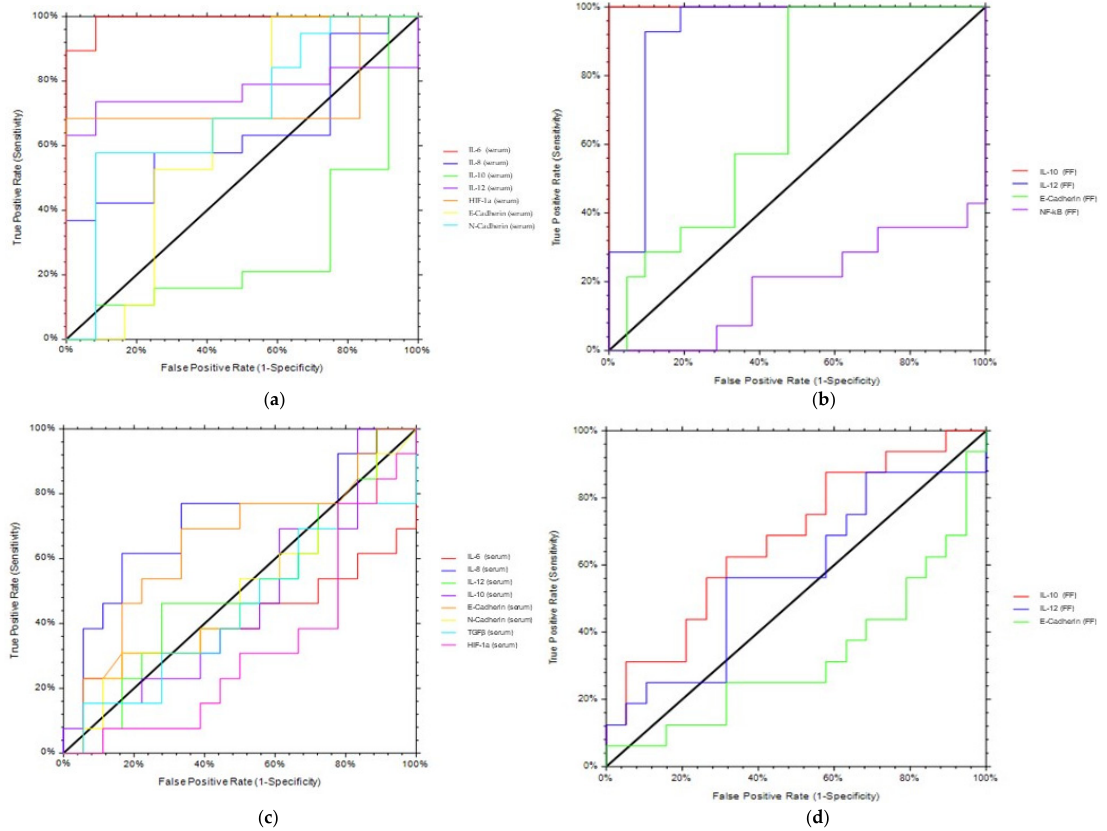
Figure 5. ROC analyses. ROC analyses of serum ( a , c ) and FF ( b , d ) parameters were performed to assess the ability to discriminate EMS patients from controls or to predict IVF outcome. AUROC, area under the receiving operating characteristic curve, and CI, confidence interval, are shown in Table 4.